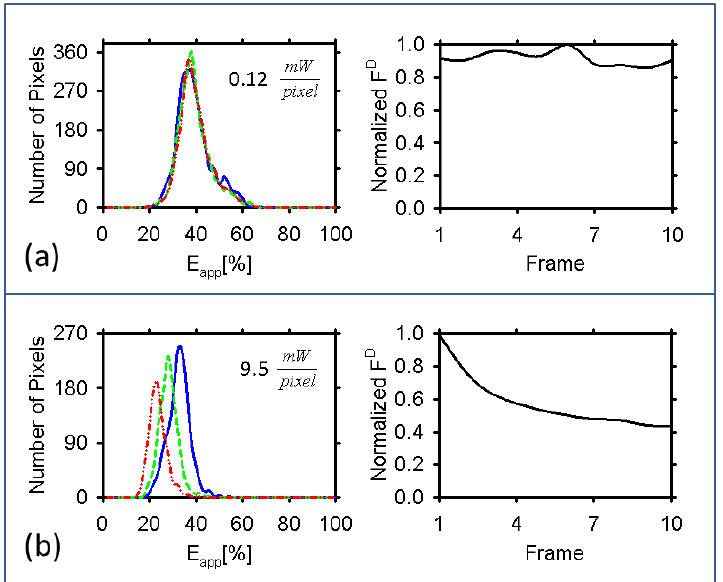
histograms of a cell calculated from the FRET efficiency map as measured Figure 4. E app using the line-scan system ( a ) and the point scan system ( b ) after repeated scans of the sample along with the normalized emission of the donors corrected for FRET. Pixels for which either k DA or k AD values were within less than 2 standard deviations of the noise level were discarded from the analysis. Blue solid line: scan 1; green dashed line: scan 4; red dashed-dotted line, scan 7. The maximum values for the F D were 38,400 and 14,775 for ( a ) and ( b ) respectively, for these